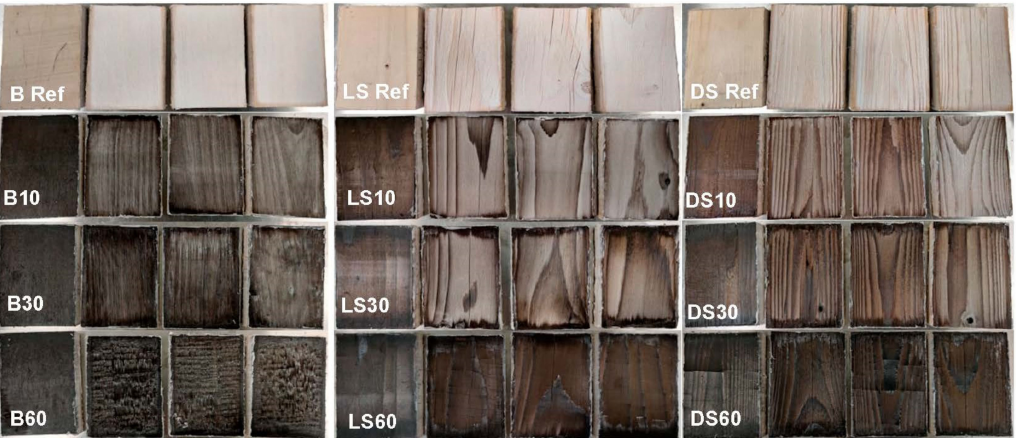
Figure 3. Weathered samples of birch (B), light spruce (LS), and dense spruce (DS) modified for different durations (10, 30 and 60 min) at 320 ◦ C. The leftmost sample in the respected series is always the unweathered reference.